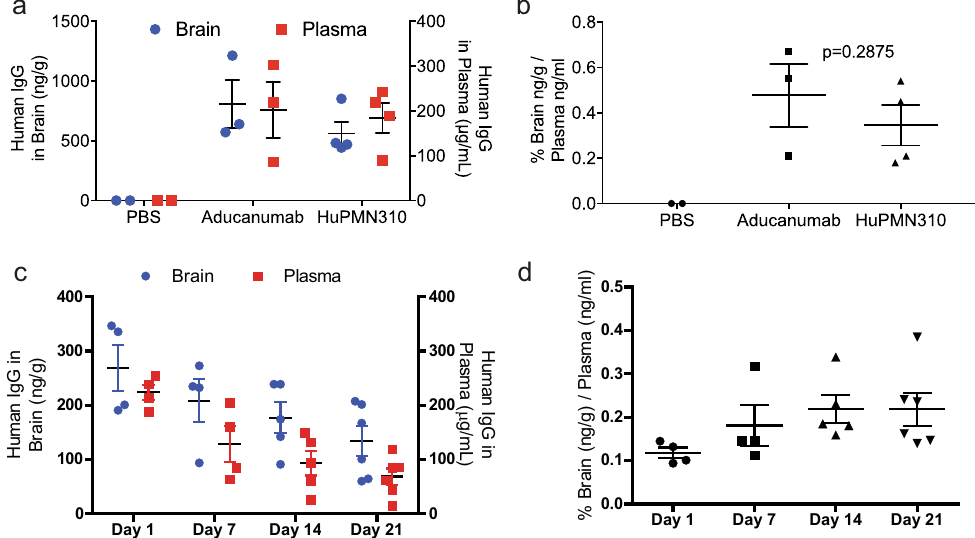
Figure 7. CNS penetrance of huPMN310. ( a , b ) Aged WT C57Bl/6 mice injected i.p. with 30 mg/kg of aducanumab (n = 3), huPMN310 (n = 4) or PBS (n = 2). ( a ) Plasma and brain levels of human IgG at 24 h. No statistically significant difference between aducanumab and huPMN310 in plasma or brain by two-way ANOVA. ( b ) CNS penetrance - Percent of human IgG in brain compared to plasma. No statistically significant difference between aducanumab and huPMN310 by Mann-Whitney test. ( c , d ) Aged APP/PS1 mice injected i.p. with 30 mg/kg of huPMN310. ( c ) Plasma and brain levels of huPMN310 at days 1–21 (n = 4–6 mice/time point). Two-way ANOVA with Sidak’s post-test test shows statistically significant differences in plasma levels between day 1 and days 7 (p = 0.0016), 14 and 21 (p < 0.0001) with no significant differences in brain levels at the different time points. ( d ) Brain:plasma ratios of huPMN310 at days 1–21. Kruskal-Wallis ANOVA with Dunn’s post- test shows a statistically significant difference only for Day 1 vs 14 (p =